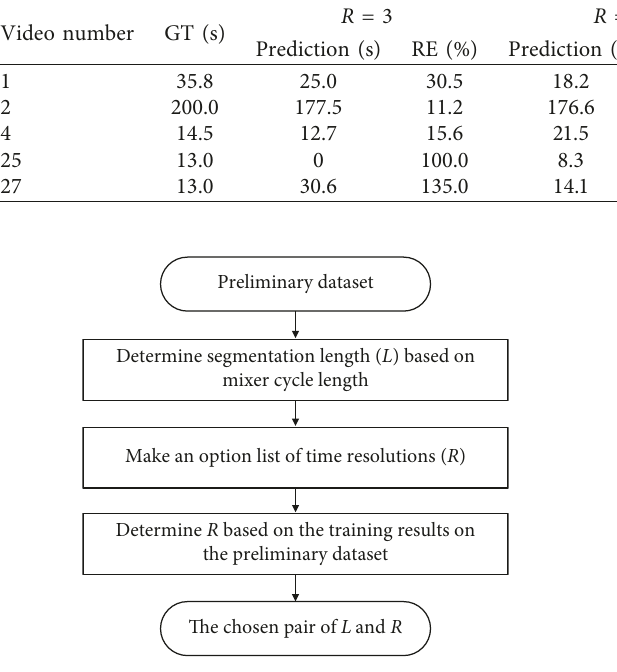
Figure 23: Downsampling parameters determination